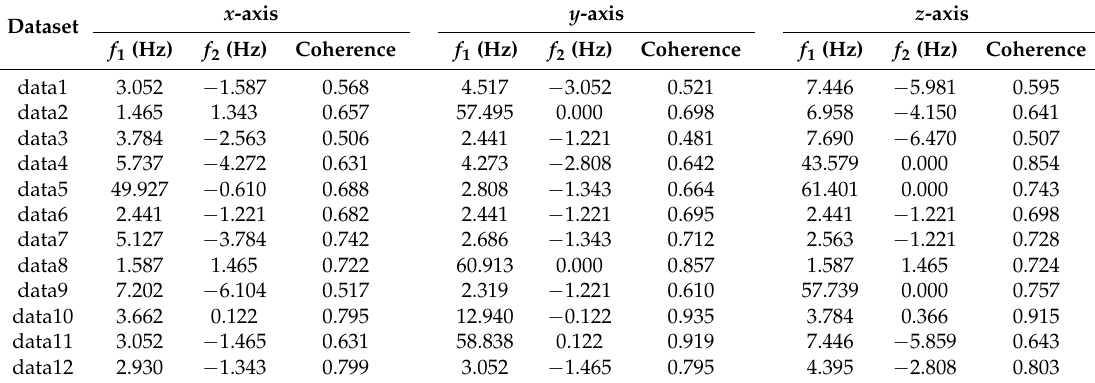
Table 2. Maximum values of the cross bicoherence of the PPG2 signal with respect to tri-axis acceleration data.